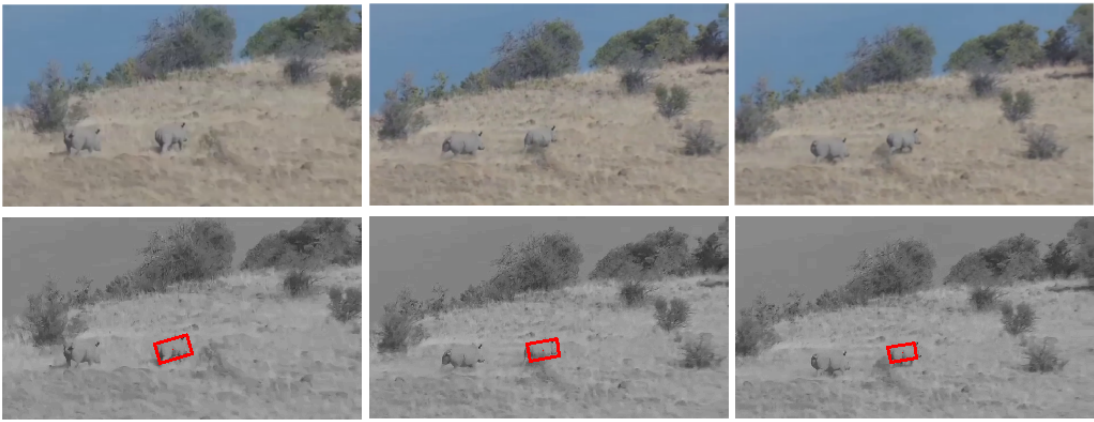
Figure 5. Visual rhino tracking. The red rectangle shows the estimated location of the running rhino.